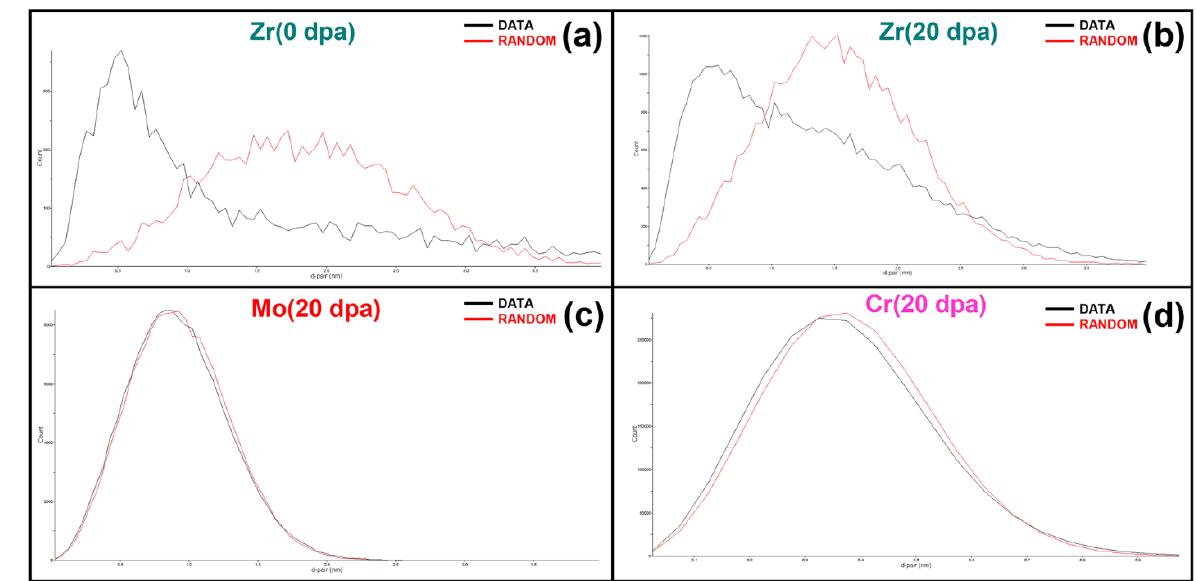
Figure A1. NND analyses of ( a ) Zr at 0 dpa, ( b ) Zr at 20 dpa, ( c ) Mo at 20 dpa, and ( d ) Cr at 20 dpa.